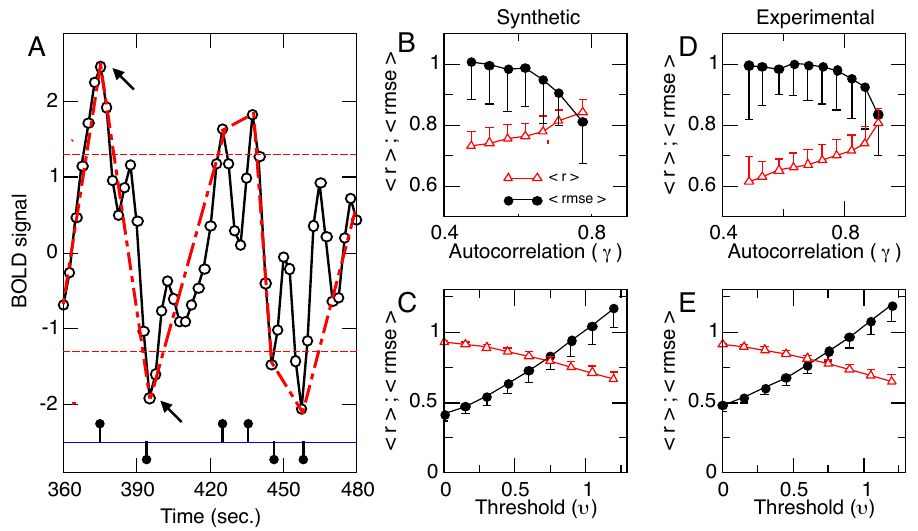
Figure 4: Why it works: The trace in Panel A is an example of a two-minute recording of a BOLD brain signal during rest (denoted by the dotted box in Fig. 2). The point process is defined by the timing of the peaks and valleys larger than a given threshold, (two are indicated here by arrows). The points, in this case, are only six (dots depicted in the bottom trace) out of the 120 samples of the original time series. The ability of these six points to preserve information about the original BOLD signal can be estimated by its similarity with a piece-wise linear time series (dashed red lines) constructed by joining the peaks and valleys. Horizontal dotted lines in Panel A denote the threshold for the example. Panels D and E correspond to the computed similarity between the BOLD signals and the piece-wise linear signals (evaluated by the correlation (cid:104) r (cid:105) and rmse values) for different autocorrelation γ and threshold ν values. Panels B and C correspond to similar calculations using synthetic time series. For Panels B and D ν was fixed at 1. For Panels C and E γ was